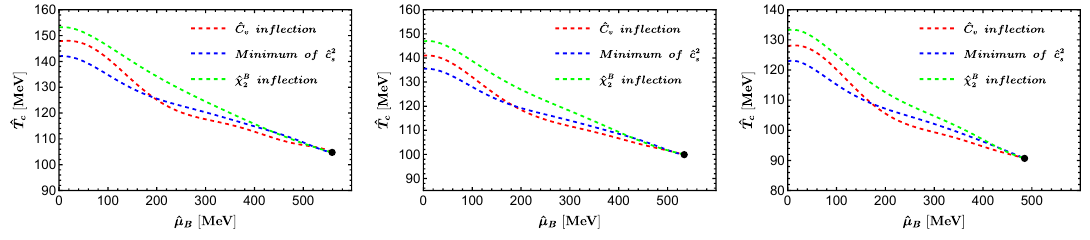
Figure 8 . The phase boundaries determined by the inflection of ˆ C v (red), the minimum of ˆ c 2 and the inflection of ˆ χ B (green) in crossover region. Three plots correspond to ω‘ = 0 , 0 . 3 and 0 . 5 2 from left to